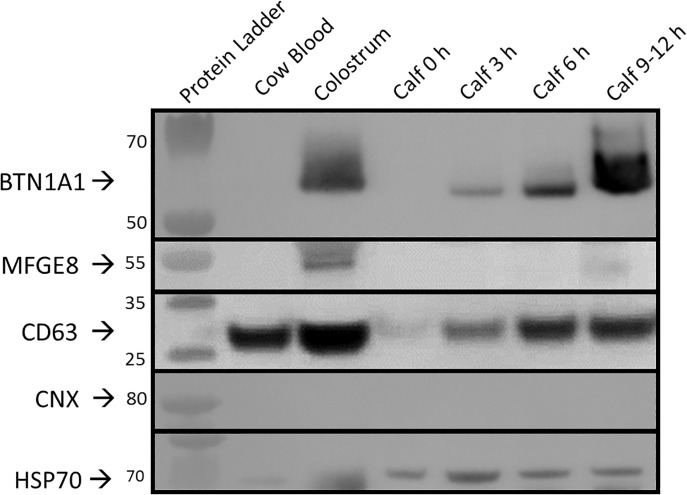
Protein expression analysis of EVs of colostral and blood EVs from adult cows and calves by Western blot.Milk specific markers BTN1A1 and MFGE8 were found in colostral and postprandial calf EV isolations but not in cow blood EVs or calf EVS pre-feeding. Presence of EV markers was confirmed by transmembrane protein CD63 and cytosolic protein HSP70 expression in all sample groups while CNX, a marker for contamination with cellular fragments, was negative. Results are representative for three biological replicates for both cow and calf samples as well as postprandial time points.